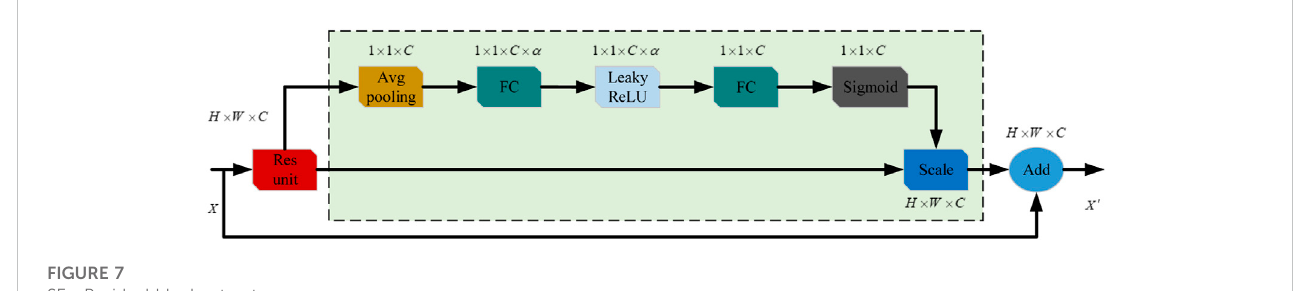
FIGURE 7 SE+ Residual blocks